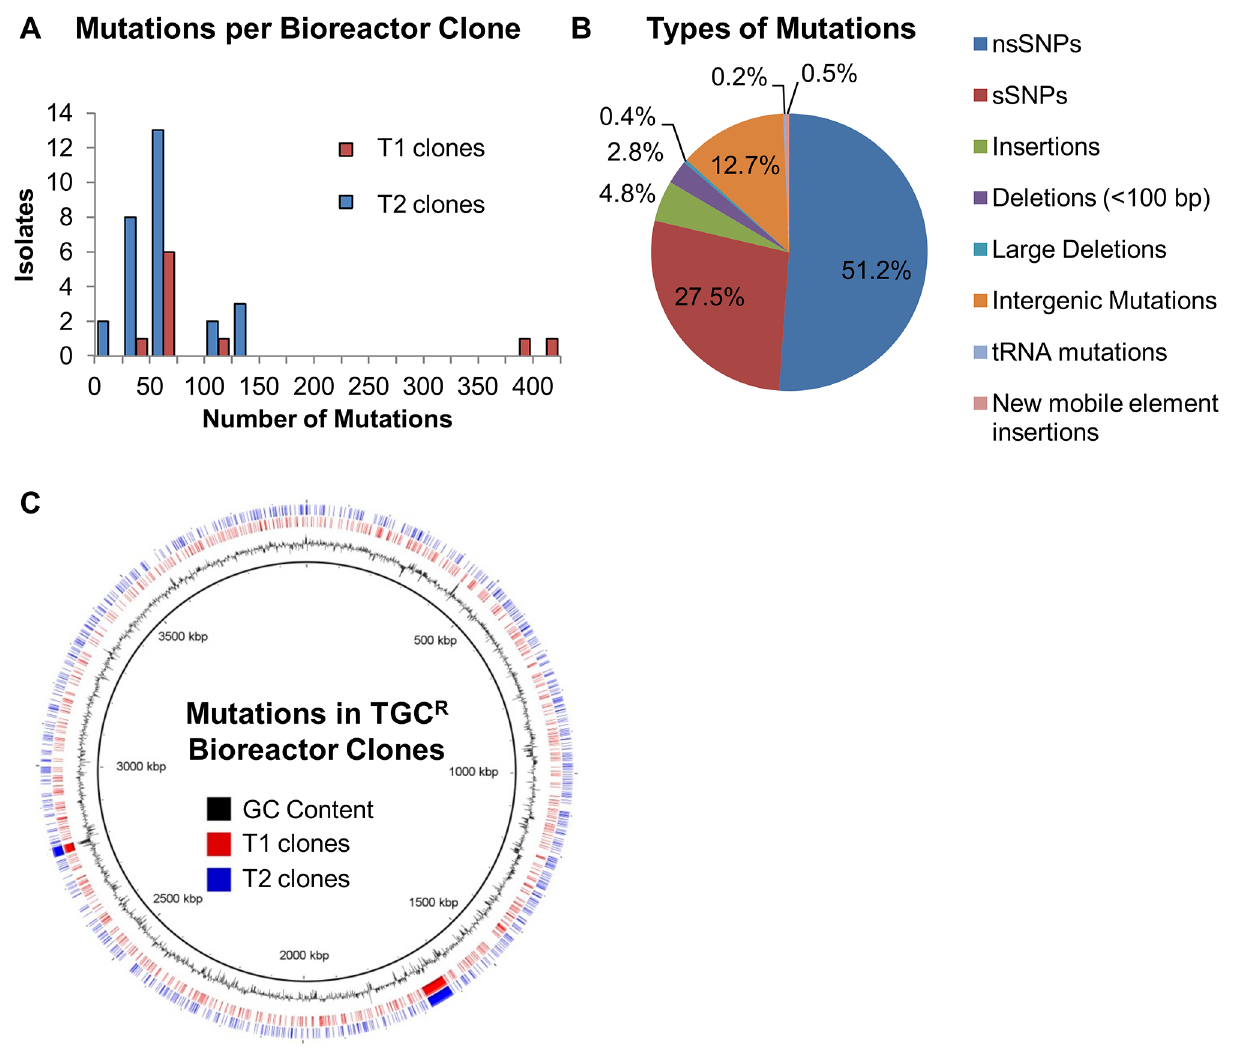
Fig 4. Whole genome sequencing of endpoint clonal isolates illustrated a wide range of mutations. (A) Total number of mutations in each clone. The two non-hypermutators (T2_F9 and T2_H3) appear on the far left of the plot with < 10 mutations while T1_H11 and T1_B5 each had 395 or 415 mutations. (B) Types of mutations for the collection of 38 isolates. (C) Locations of the mutations in the AB210M genome (Trials 1, red; Trial 2,